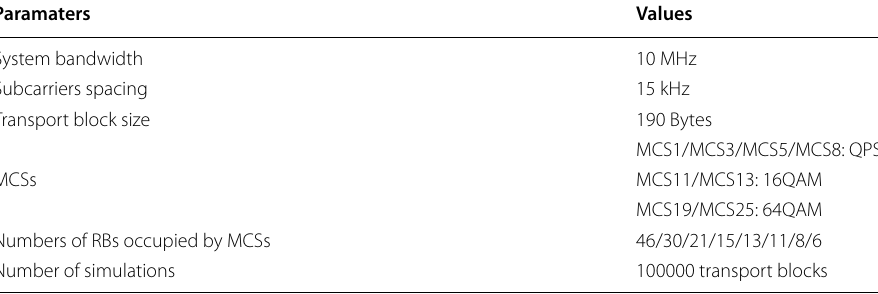
Table 2 Parameters of link-level simulation Paramaters Values System bandwidth 10 MHz Subcarriers spacing 15 kHz Transport block size 190 Bytes MCSs Numbers of RBs occupied by MCSs Number of simulations 100000 transport